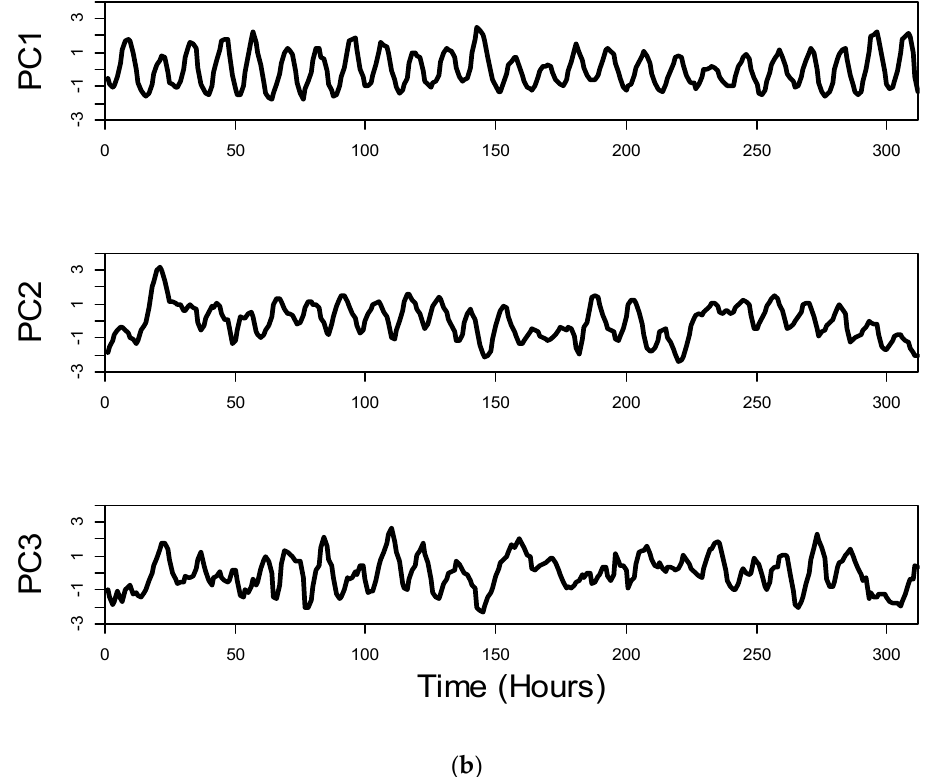
Figure 11. The first three EOF principal components (PCs): ( a ) model results and ( b ) HFR data.